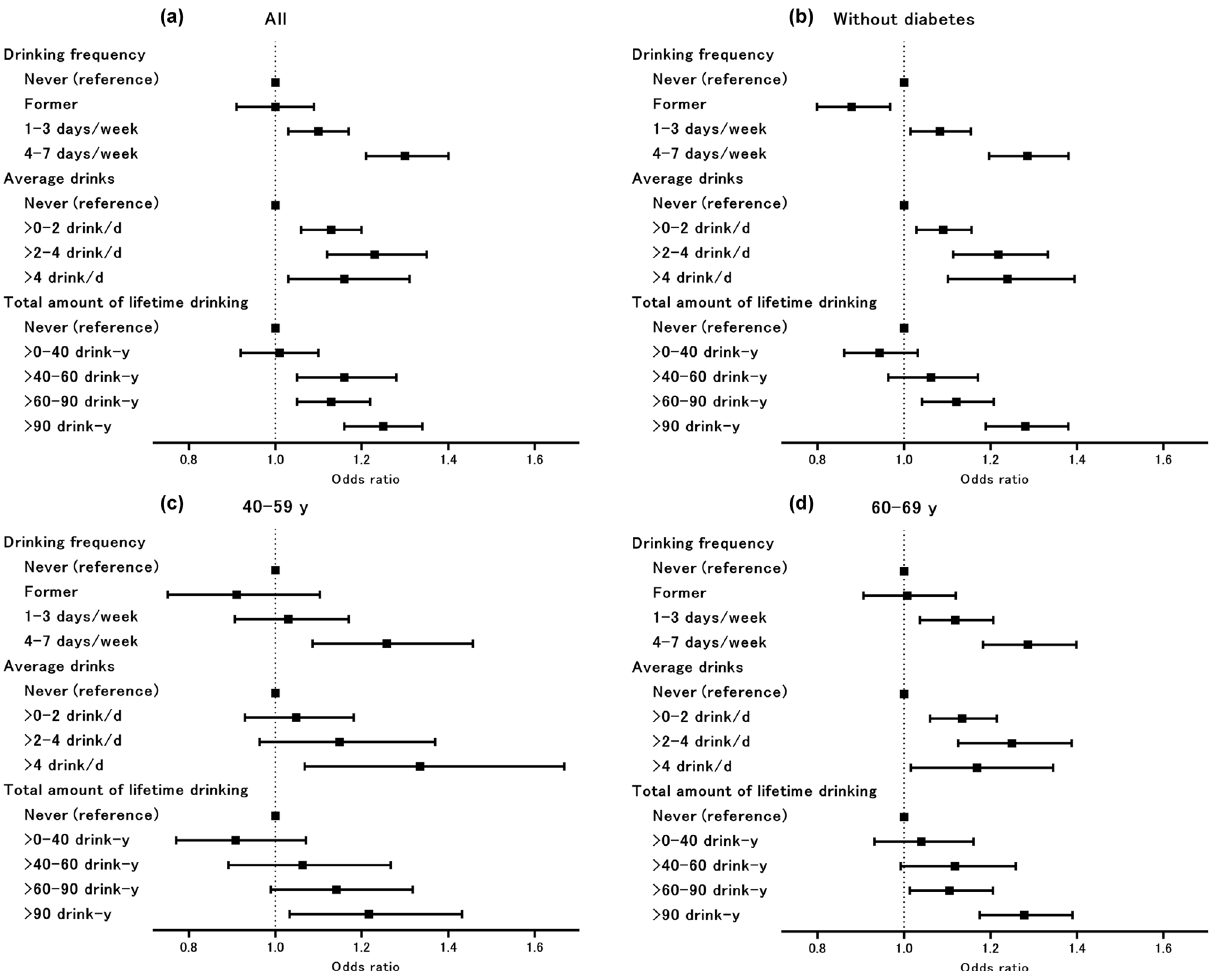
Figure 1. Odds ratios for incident cataract surgery by alcohol use patterns. The odds ratio (dot) and 95% CI (bar) were estimated via conditional logistic regression with multiple imputations, matched for age, sex, admission year, and admitting hospital, and additionally adjusted for smoking history, lifestyle-related comorbidities (hypertension, hyperlipidaemia, diabetes, and obesity), occupational radiation exposure, and outdoor work. ( a ) Conducted among the total population; ( b ) excluded patients with diabetes; ( c ) aged 40–59 years; ( d ) aged 60–69